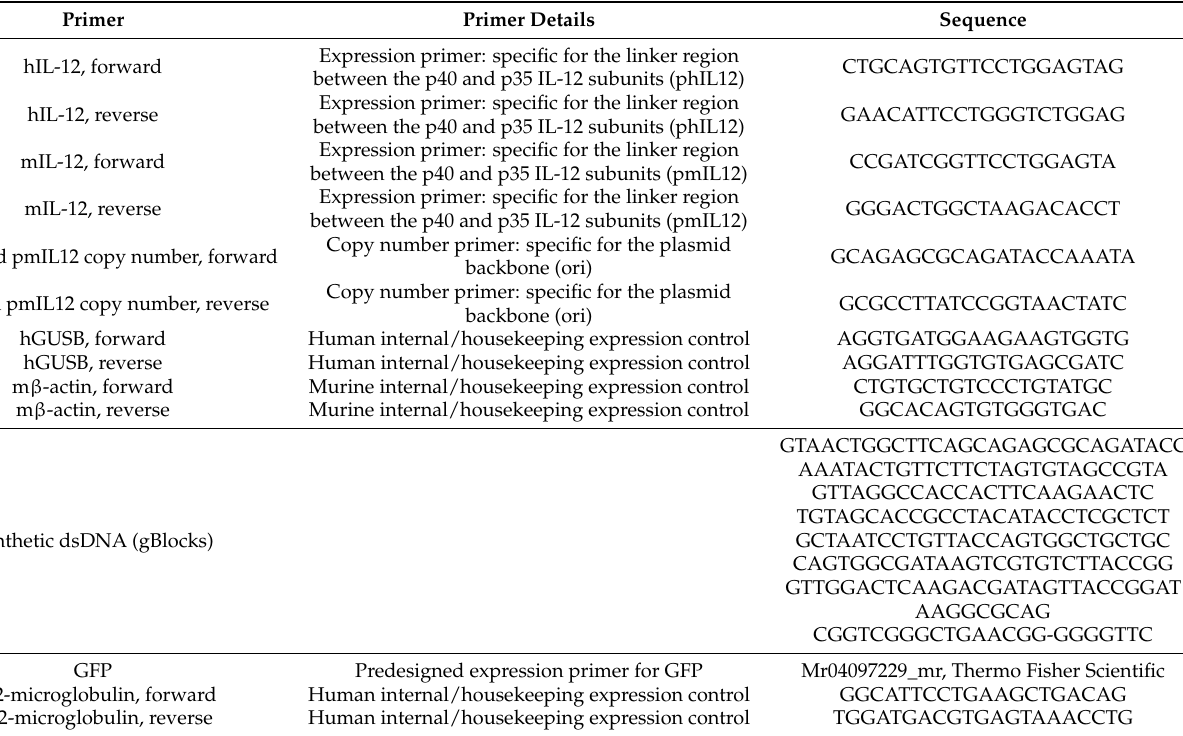
Table 1. Details of the primers used for